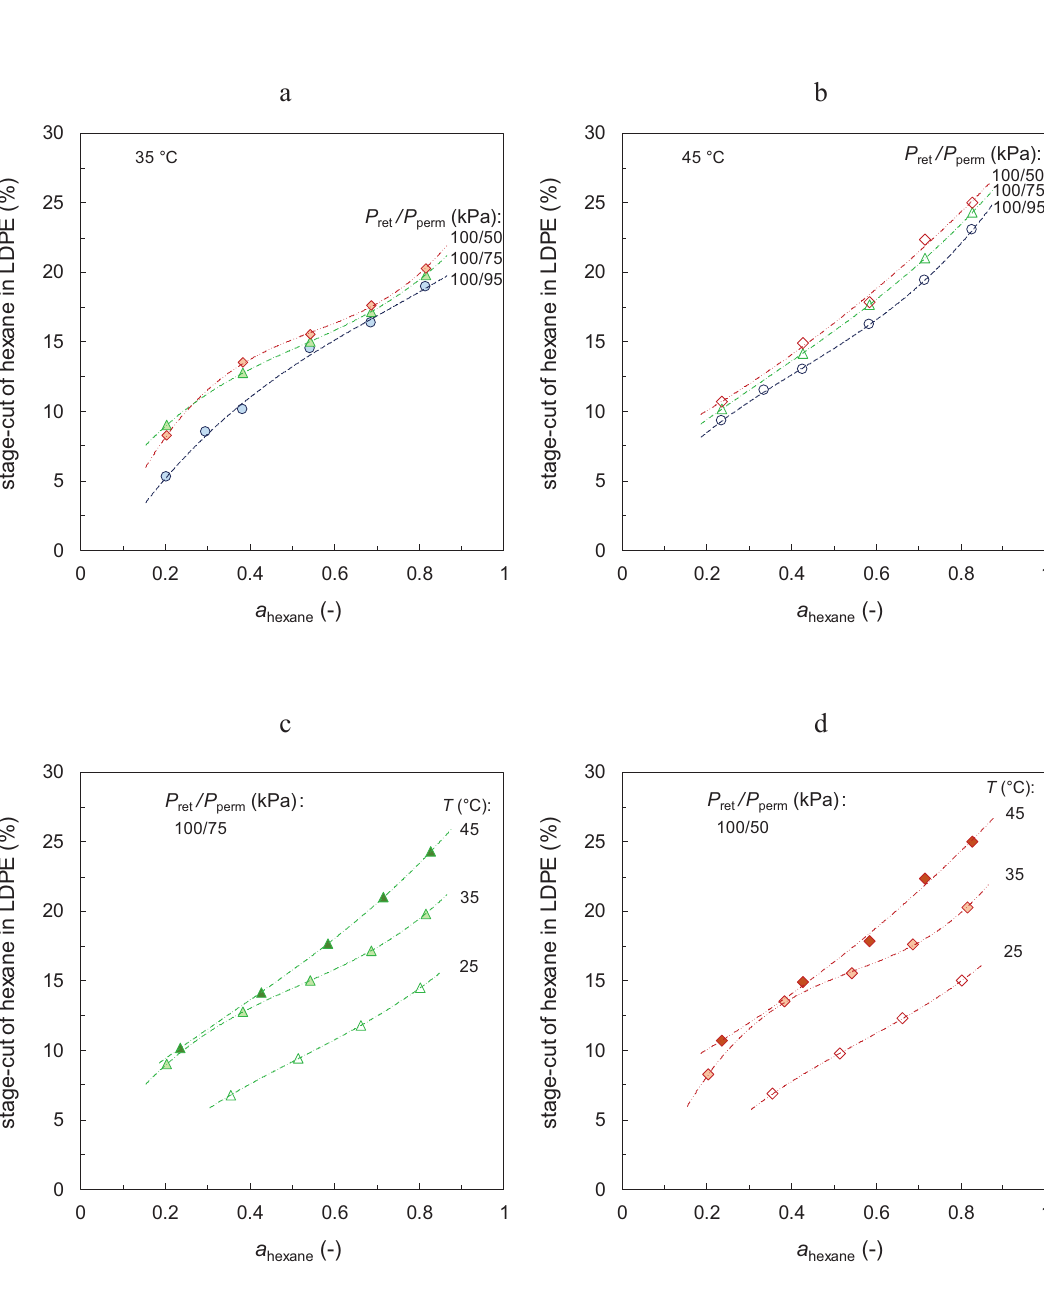
Fig. S3 – Hexane stage-cut in LDPE membrane: activity dependence at three different trans-membrane pressures at a) 35 °C and b) 45 °C, activity dependence at three temperatures at trans-membrane pressure c) 25 kPa and d) 50 kPa; The lines are intended as a guide to the eye.